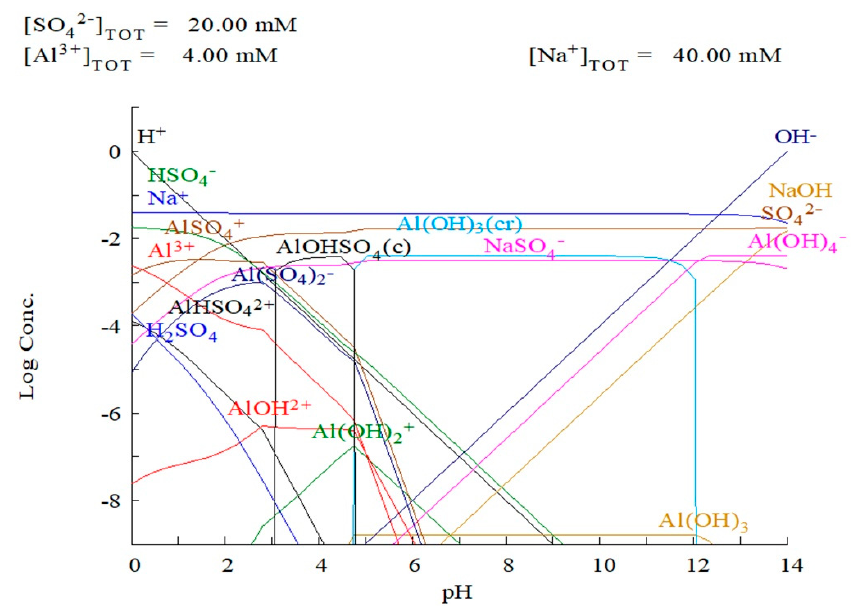
Figure 9. Chemical speciation diagram for aluminum, generated from Hydra-Medusa software. Figure 10 present the XRD diffractogram, where there was an absence of copper.